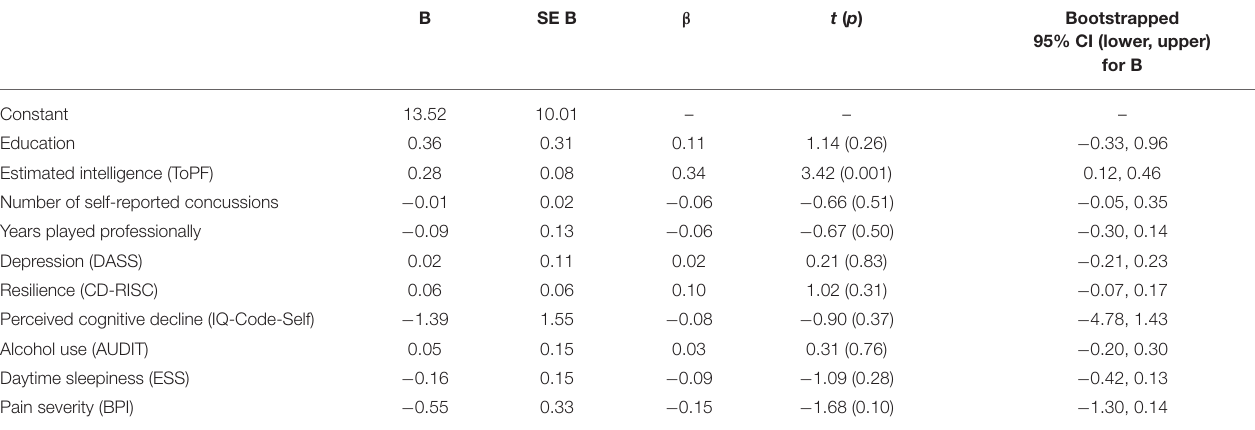
TABLE 8 | Simultaneous multiple regression model with the Memory Composite Score as the